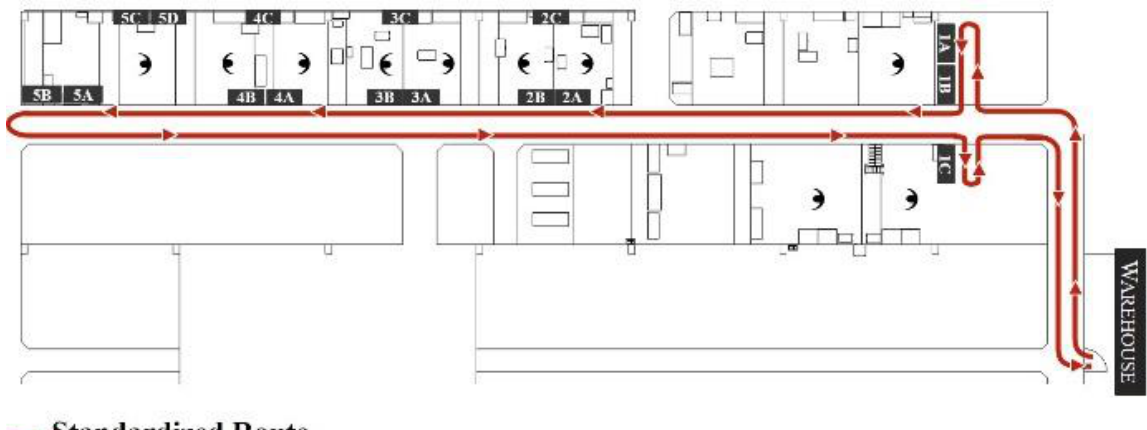
Figure 7. Standardized route of the Mizusumashi for the supply cycle of the